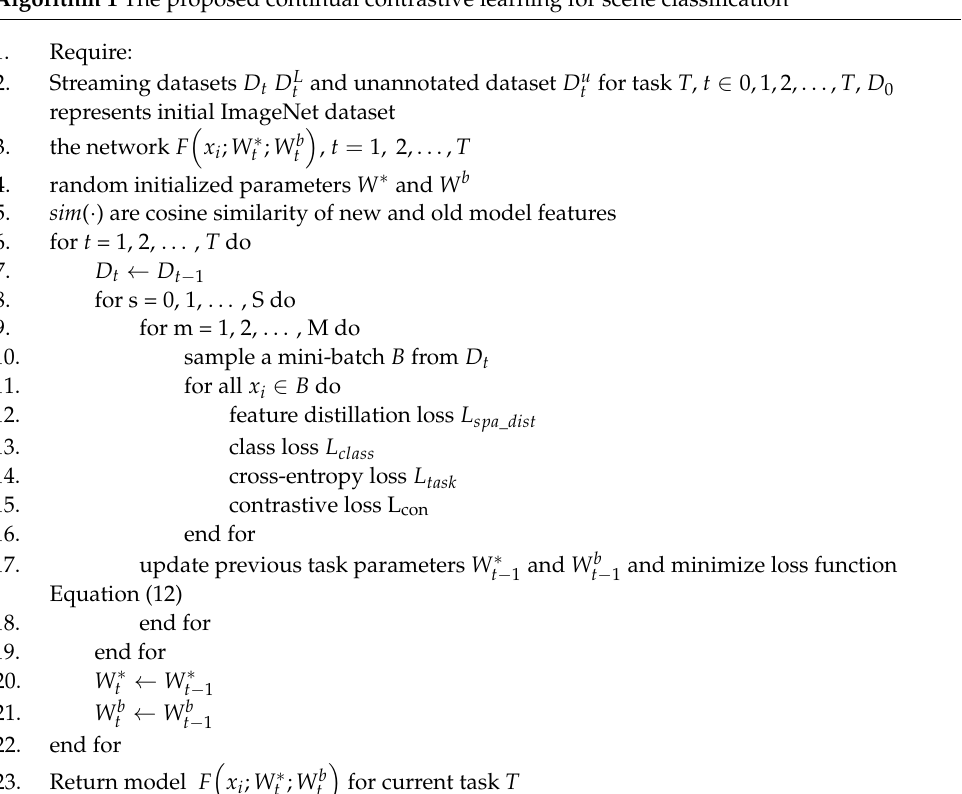
Algorithm 1 The proposed continual contrastive learning for scene